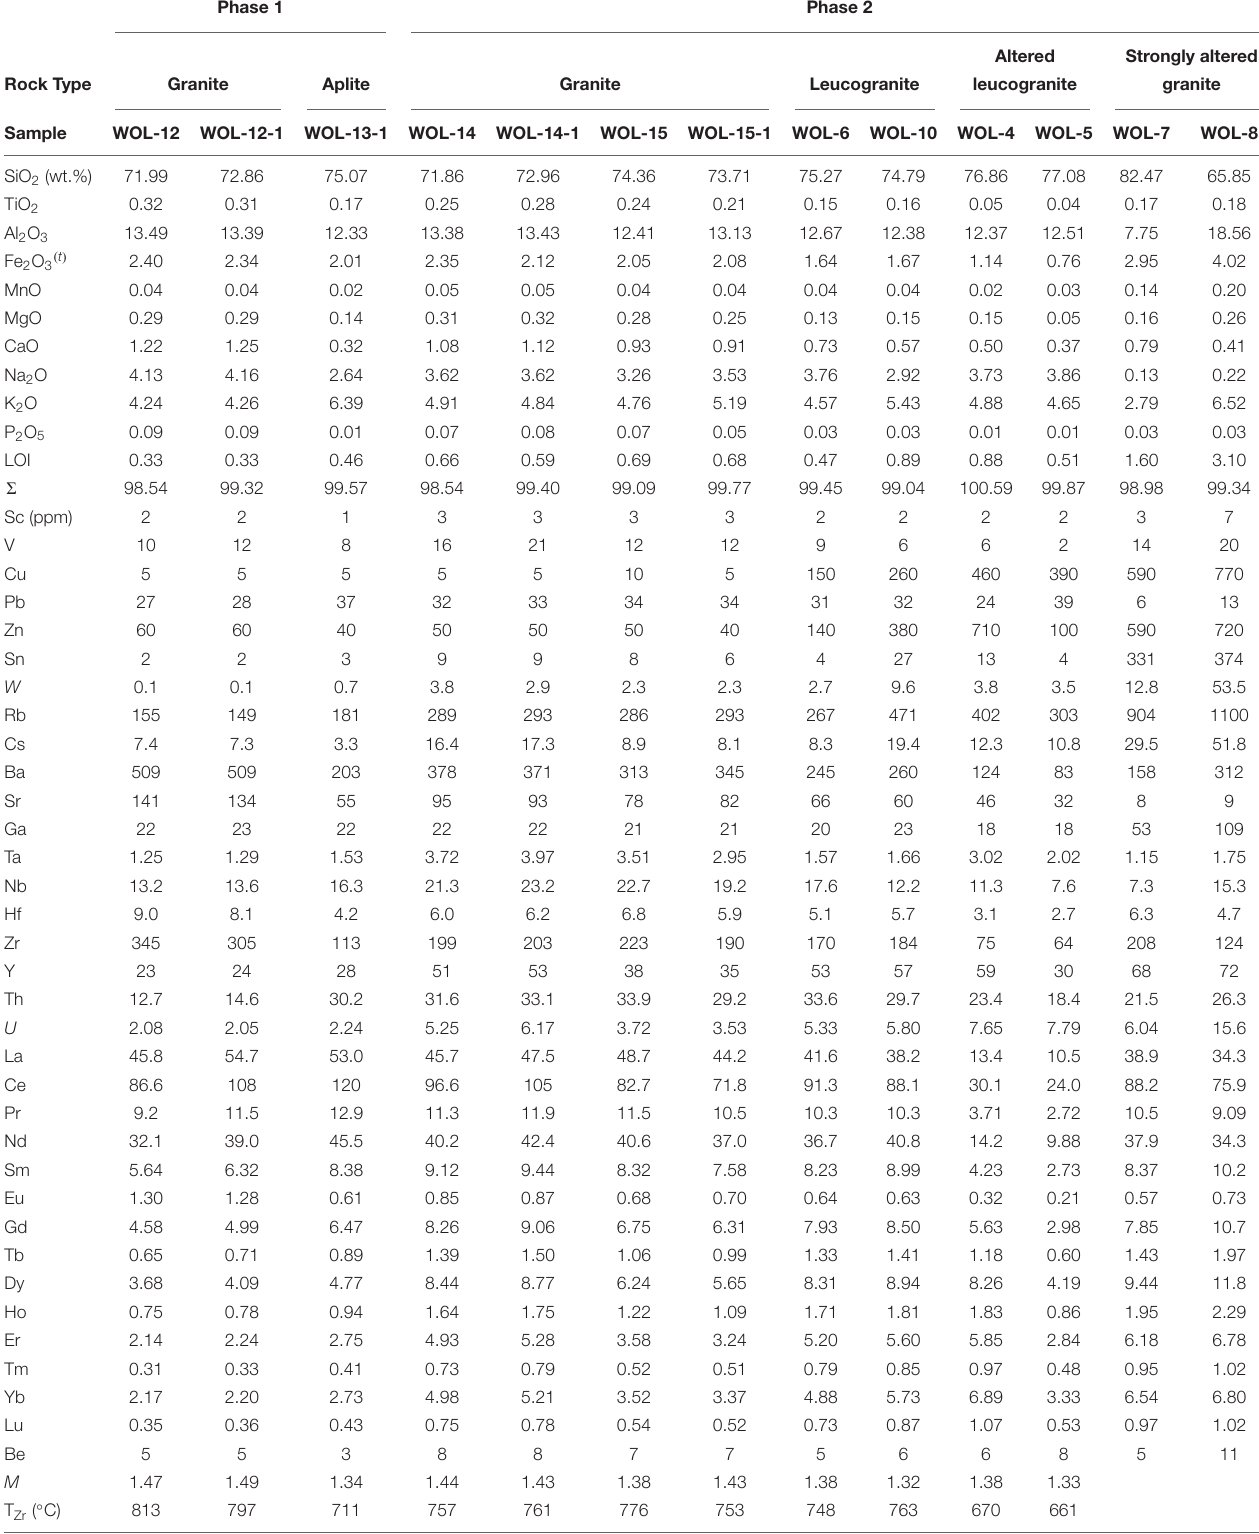
TABLE 1 | Major and trace element compositions of granites from the Tukhum